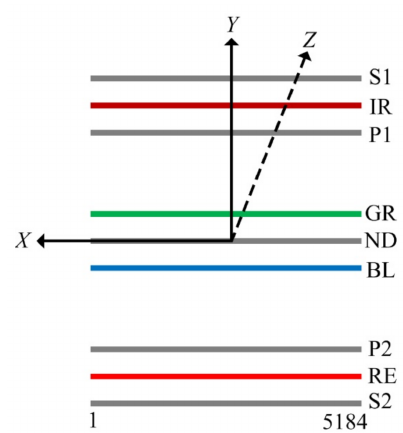
Figure 2. Focal plane arrangement of the High Resolution Stereo Camera (HRSC). S1, S2, P1, P2 and ND represent five panchromatic channels; IR represents near-infrared channel; RE, GR and BL represent red, green and blue channels respectively.